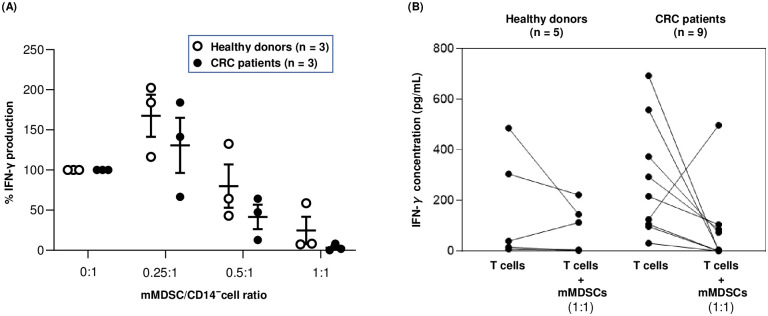
In vitro suppressive activity of mMDSCs.(A) CD14− cells or (B) T cells from healthy donors and CRC patients were stimulated with anti-CD2/anti-CD3/anti-CD28 antibody conjugated beads in the absence or presence of autologous mMDSCs. Culture supernatant was collected at 5 d to measure IFN-γ concentration.